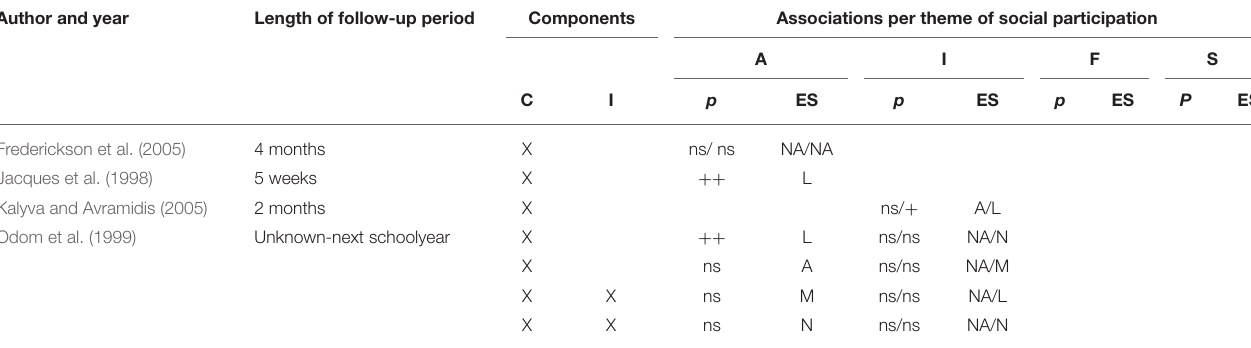
TABLE 9 | Summary of studies examining long-term effects on the social participation of students with disabilities. Author and year Length of follow-up period